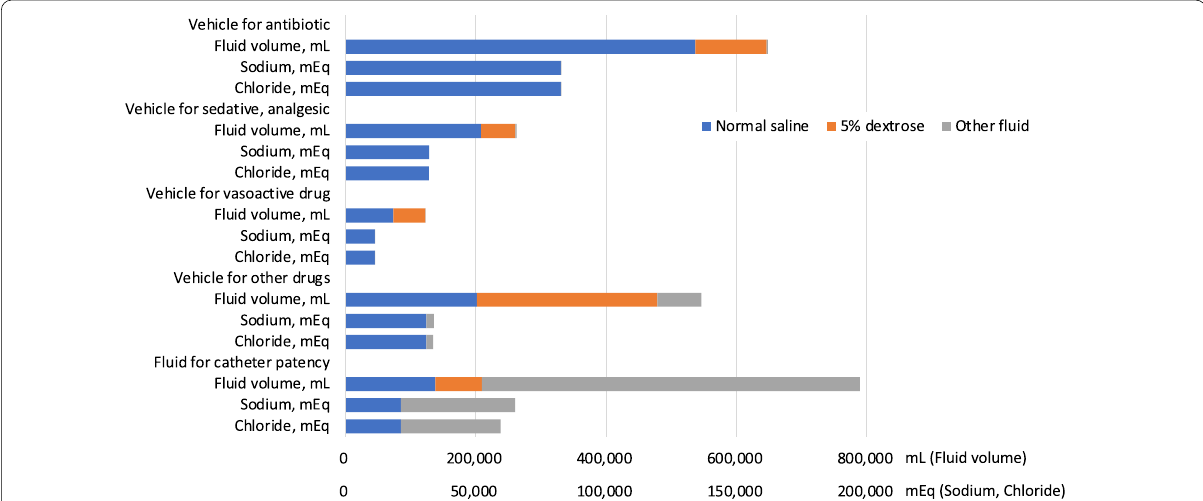
Fig. 4 Details of total amount of fluid volume, sodium, and chloride burden due to fluid creep among the 588 patients. Each result was calculated from intravenous fluids administered in 588 patients for 2387